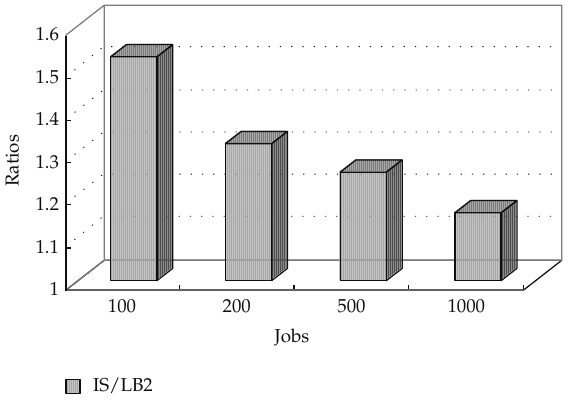
Figure 1: Ratios of IS/LB2 with m (cid:9)